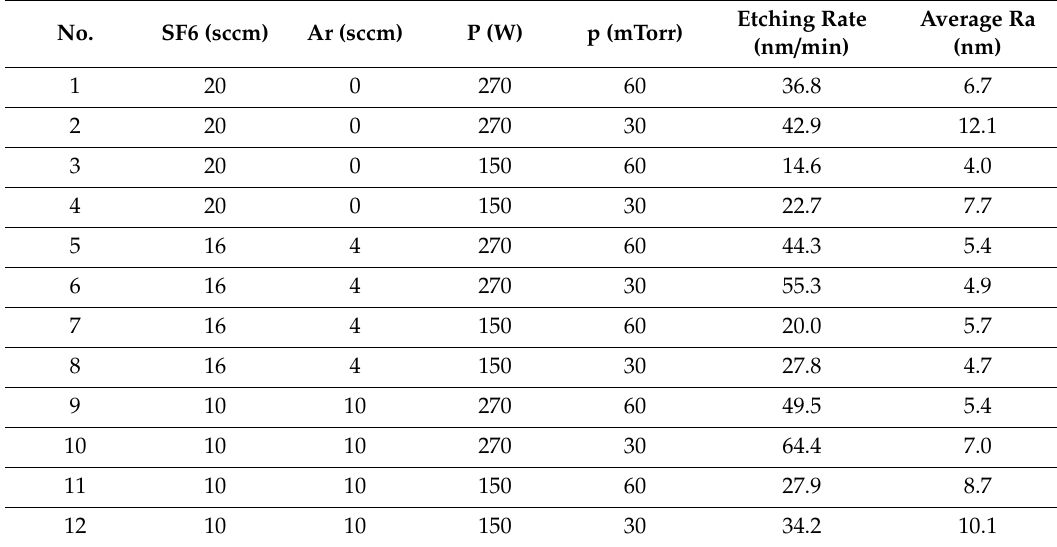
Table 1. RIE parameters and resulting etching rates and average surface roughness Ra.